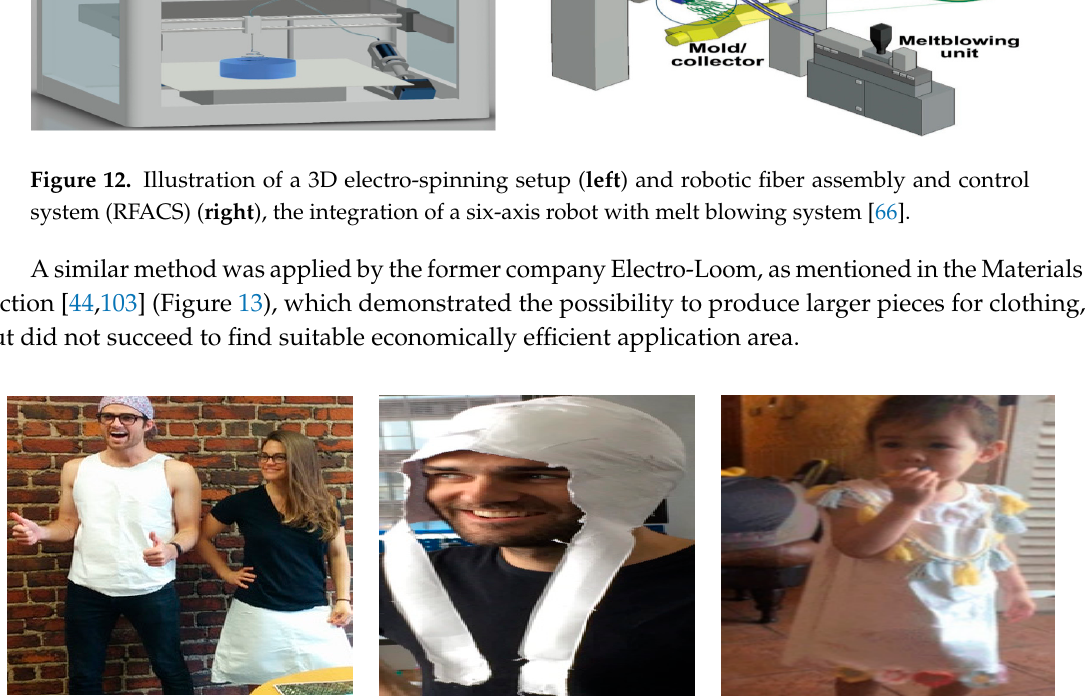
Figure 11. Samples of the 3D printed textile structures and clothes [57,58,66,100]